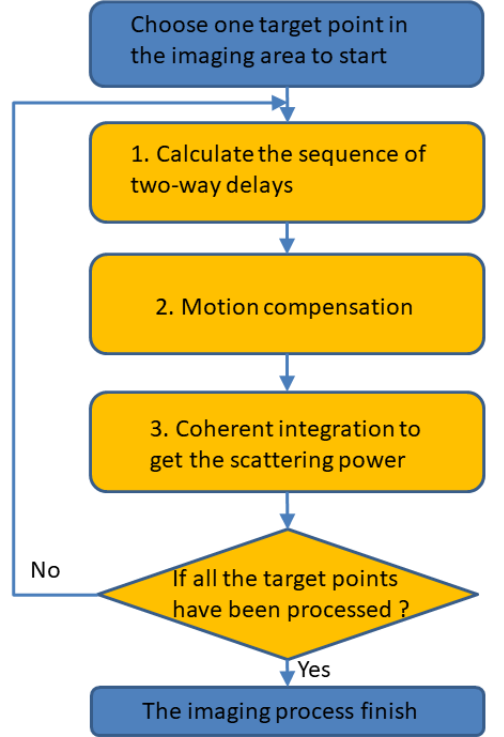
Figure 1. The flowchart of BP algorithm. The steps indicated in yellow form a loop structure.